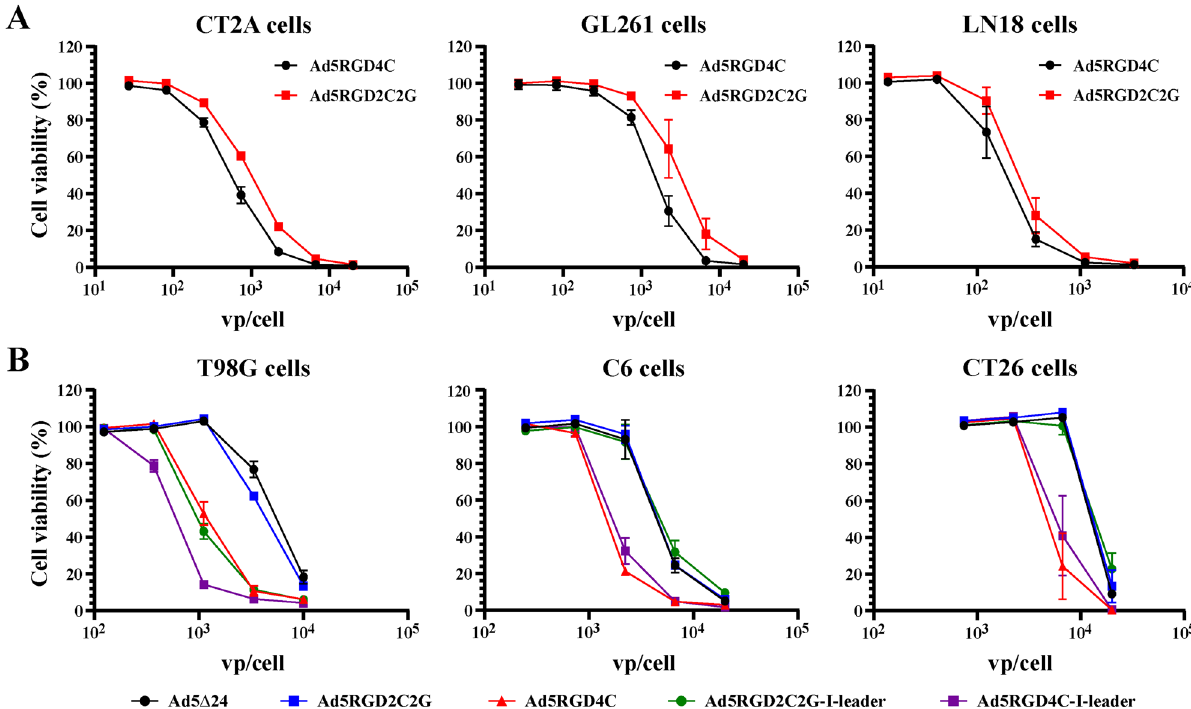
Figure 5. A cysteine-to-glycine substitution after the RGD motif within the RGD-4C peptide (RGD-2C2G) in the HI loop of the fiber knob domain reduced the cytotoxic efficacy in human and rodent cell lines. ( A ) The AlamarBlue cell viability assay of rAd infected glioma cells. Cells (5 × 10 3 per well for human and 2.5 × 10 3 per well for murine cells) were infected in suspension with rAds in a serial one-third dilution starting from 2 × 10 4 vp/cell for murine cells and 10 4 vp/cell for human cells. Five days after infection, the cell viability was measured. Data are presented as mean ± SD of two independent experiments in triplicate. ( B ) Comparative cytotoxic effect of Ad5-delta-24, Ad5-delta-24-RGD4C, Ad5-delta-24-RGD2C2G, Ad5-delta-24-RGD4C-I-leader (Q125Stop), and Ad5-delta-24-RGD2C2G-I-leader (Q125Stop) in human and murine cells. Cells were treated and analyzed as in ( A ). For T98G cells, cell viability was measured seven days post-infection. Data are represented as mean ± SD of two independent experiments in